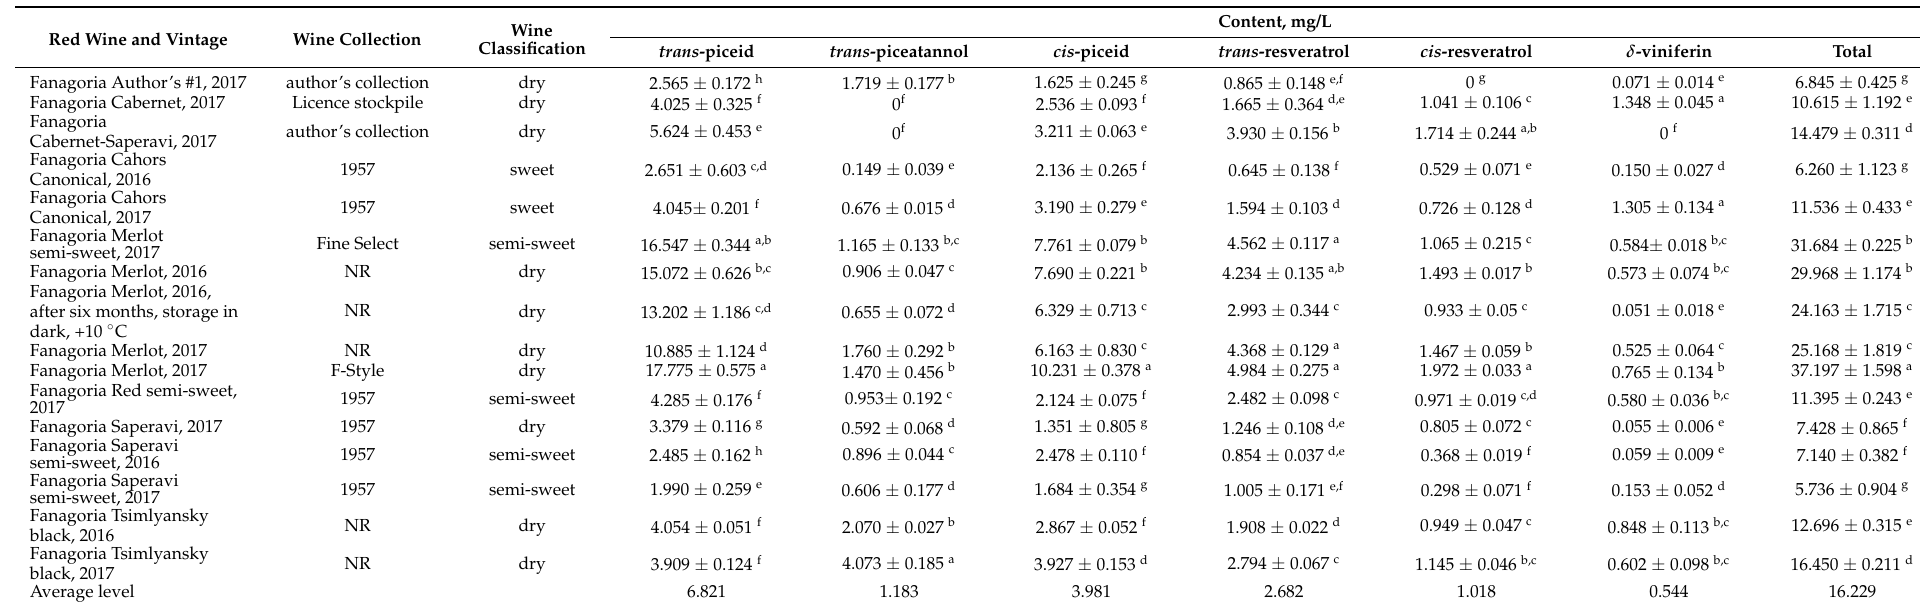
Table 3. The content of stilbenes in the red Russian Fanogoria wines